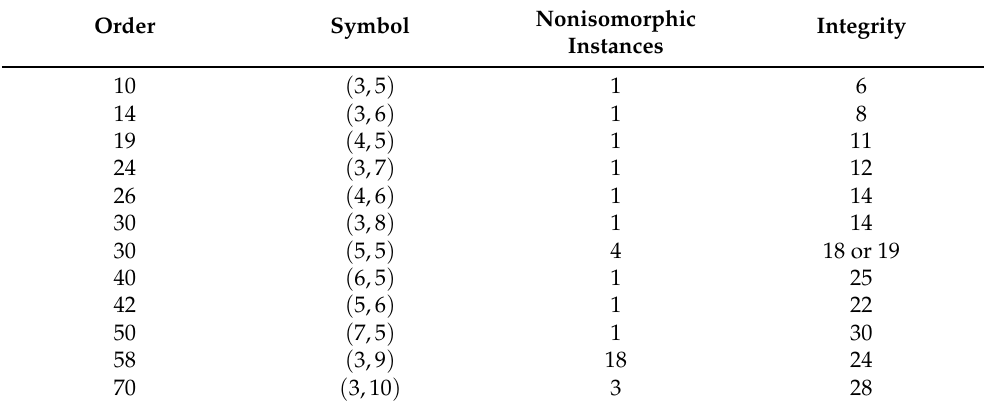
Table 5. Integrity of small cage graphs. Order